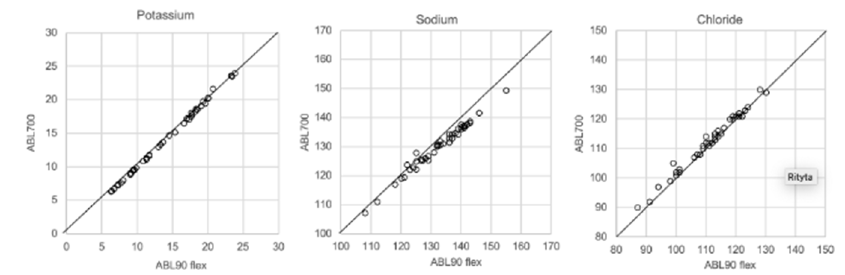
Figure 1. Comparison results using ABL90 flex and ABL700.